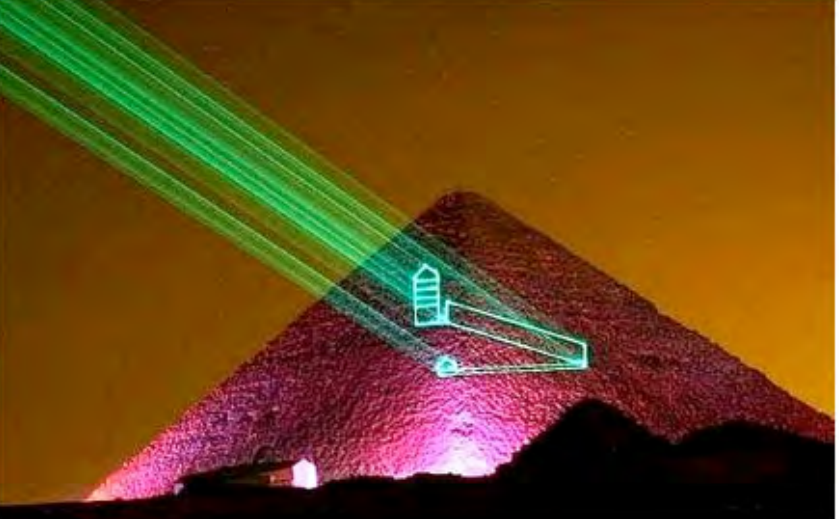
Figure 8. Laser tagging on historical buildings